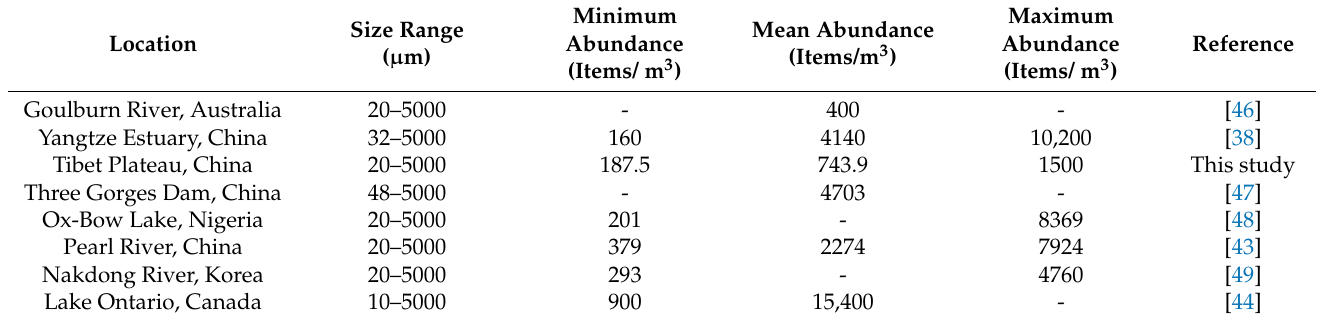
Table 1. Studies on MP abundance in different freshwater